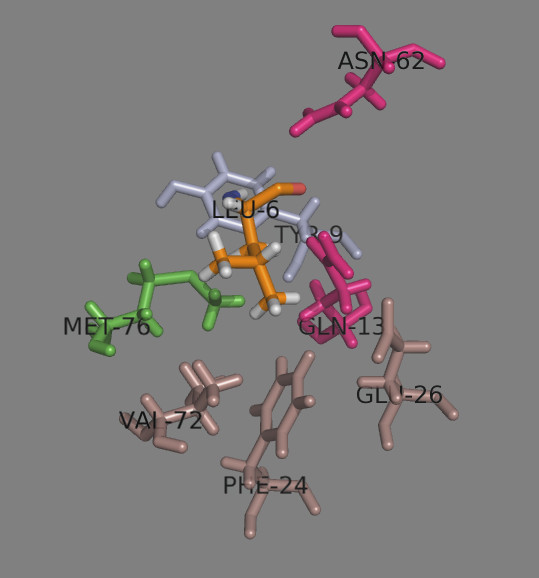
Peptide binding pocket 4. The α chain residues are shown in light blue, the β chain residues – in darksalmon. The dimorphic Met/Val76β is shown in green. Asn62α and Gln13β (given in magenta) make H-bonds with p4 residue Leu (given as LEU-6 in orange).